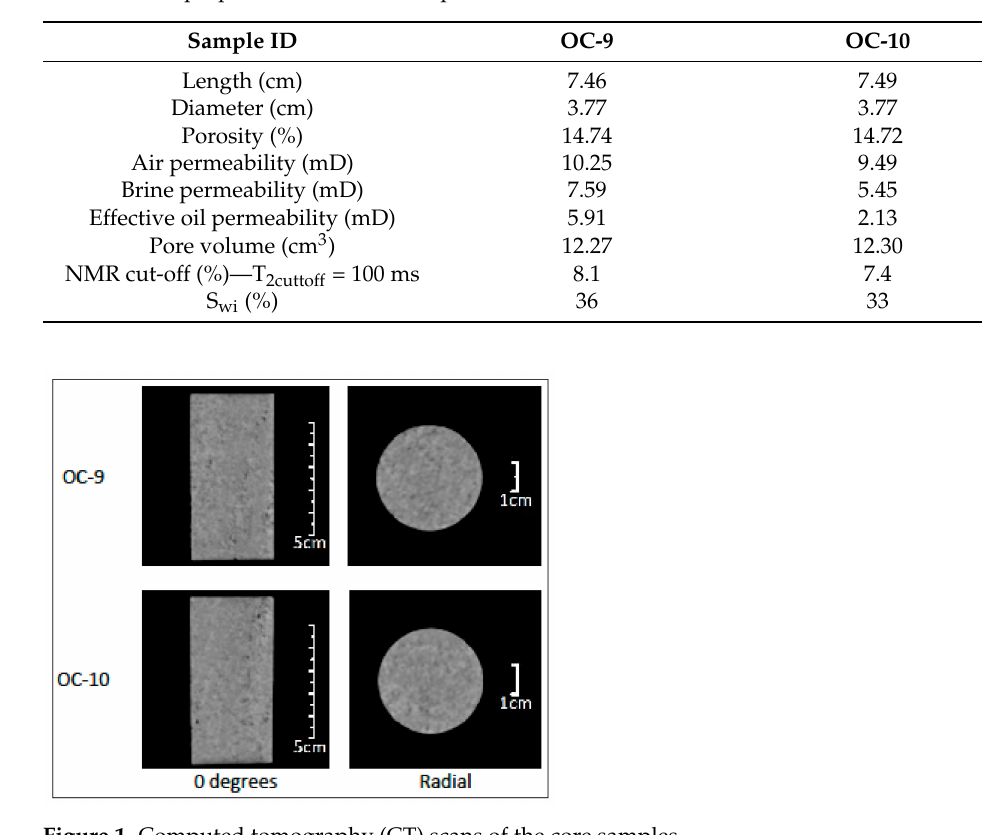
Table 2. Basic properties of the core samples.